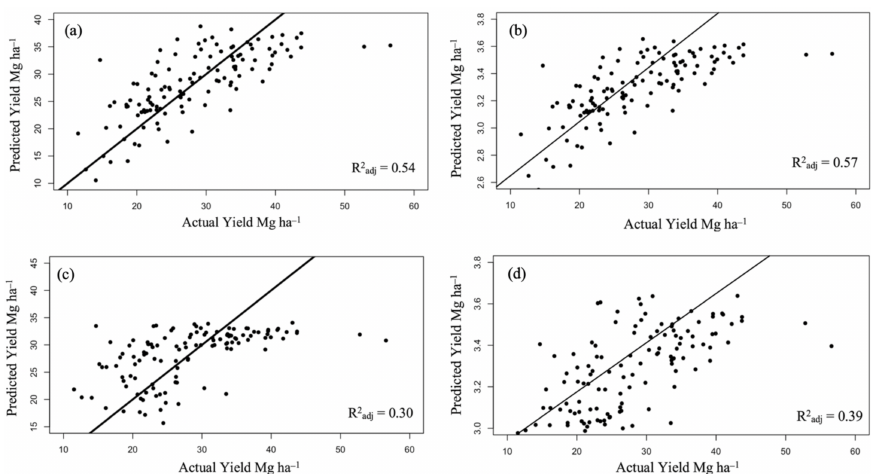
Figure 6. Relationship between the actual and predicted total potato yield for both sensing dates in 2018 and 2019: ( a ) 5 August, the untransformed model; ( b ) 5 August, the transformed model; ( c ) 16 August, the untransformed model; ( d ) 16 August, the transformed model.